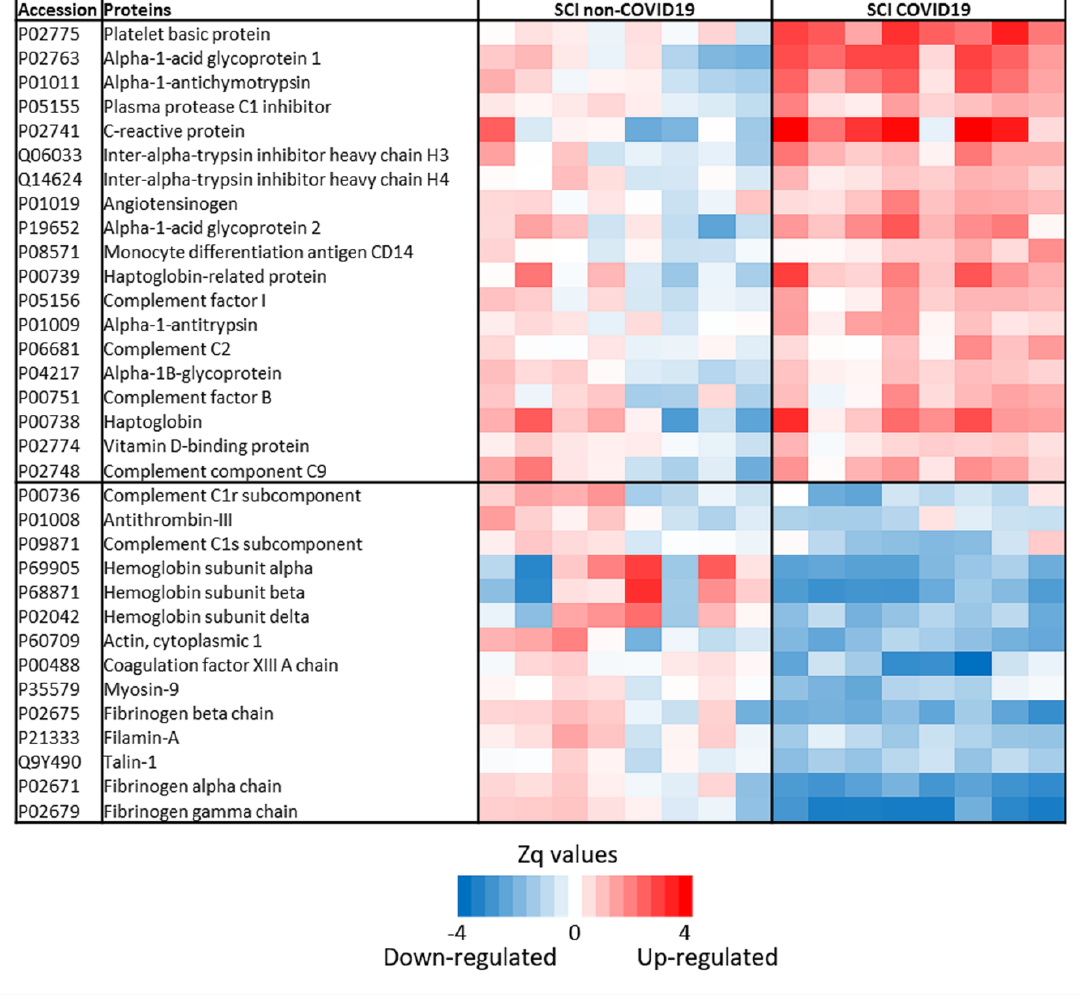
Figure 2. Differentially expressed proteins identified by Tandem Mass Tag labelling. Heatmap representing the changes in protein abundance between the groups. Zq (standardized log2 ratio) values are represented in a color scale (red means up-regulated and blue down-regulated). The protein name and UniProt accession codes are shown. Two-tailed Student t -tests were employed to calculate the differences between groups.